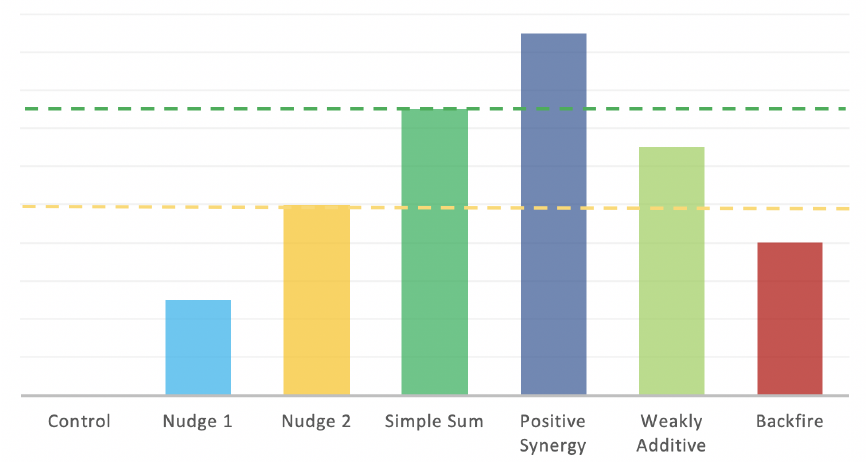
Figure 1. Possible interactions among